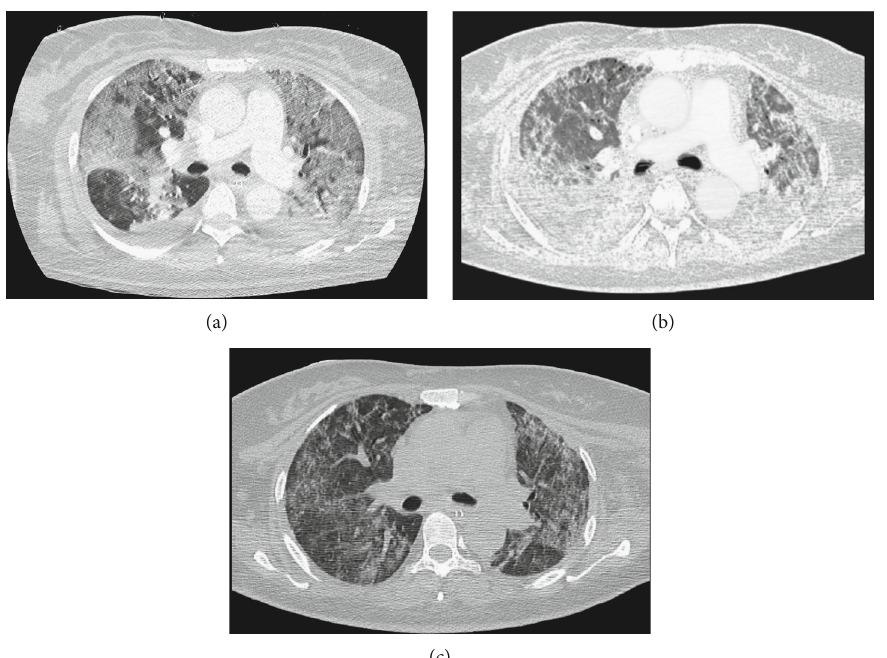
Figure 1: Axial chest computed tomography scan. (a) Before the fi rst extracorporeal membrane oxygenation support. Di ff use bilateral ground glass opacity pattern and right pleural e ff usion are shown. (b) During the fi rst extracorporeal membrane oxygenation support. Thickening of interstitial septa and di ff use crazy paving are shown. (c) After the fi rst decannulation of extracorporeal membrane oxygenation. Lung aeration improved bilaterally with partial resolution of ground glass